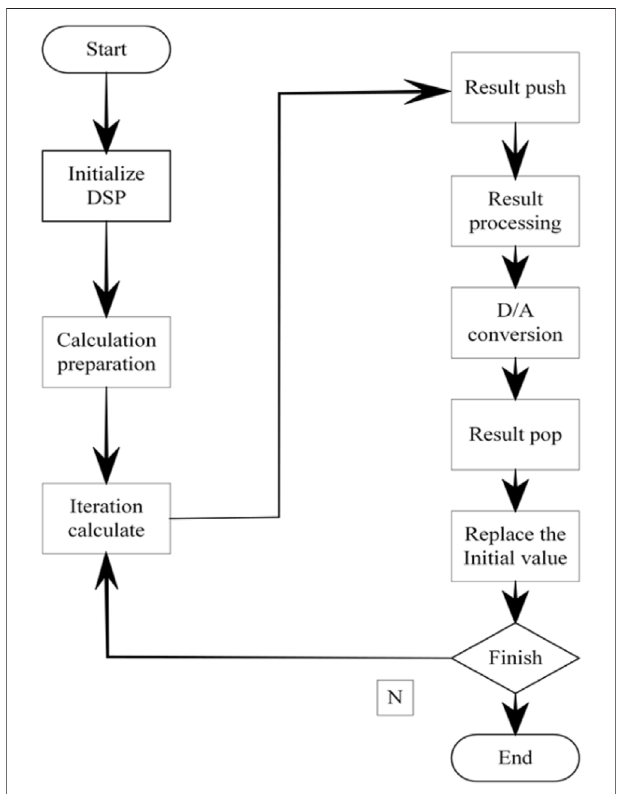
FIGURE 10 | Programming fl ow of DSP implementation.